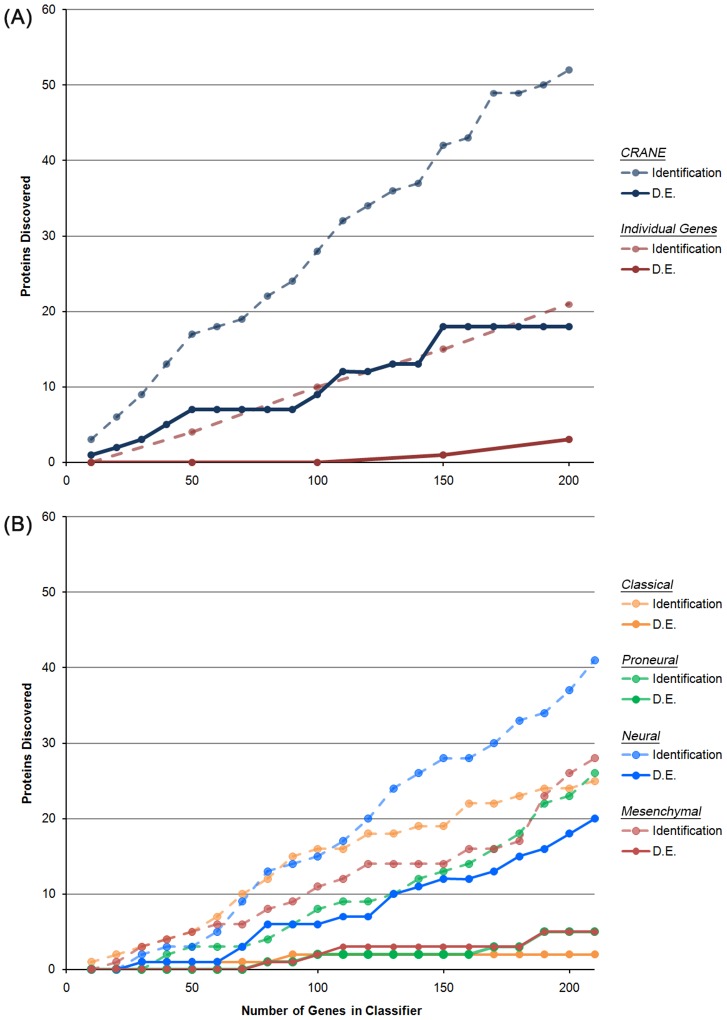
Proteomic detection and dysregulation of biomarkers discovered using various pipelines.(A) Comparison of the number of proteomic targets identified using a network-based algorithm for identifying combinatorial gene markers (“CRANE”) versus one using individual differentially expressed genes (“Individual Gene Markers”). (B) Comparison of the number of proteomic targets identified using the subtypes identified by Verhaak et al. We plot the total number of classifier targets detected in the proteomic experiment (“Identification”), as well as the subset of classifier genes showing evidence for differential expression (p-value≤0.05) at the protein level (“D.E.”).